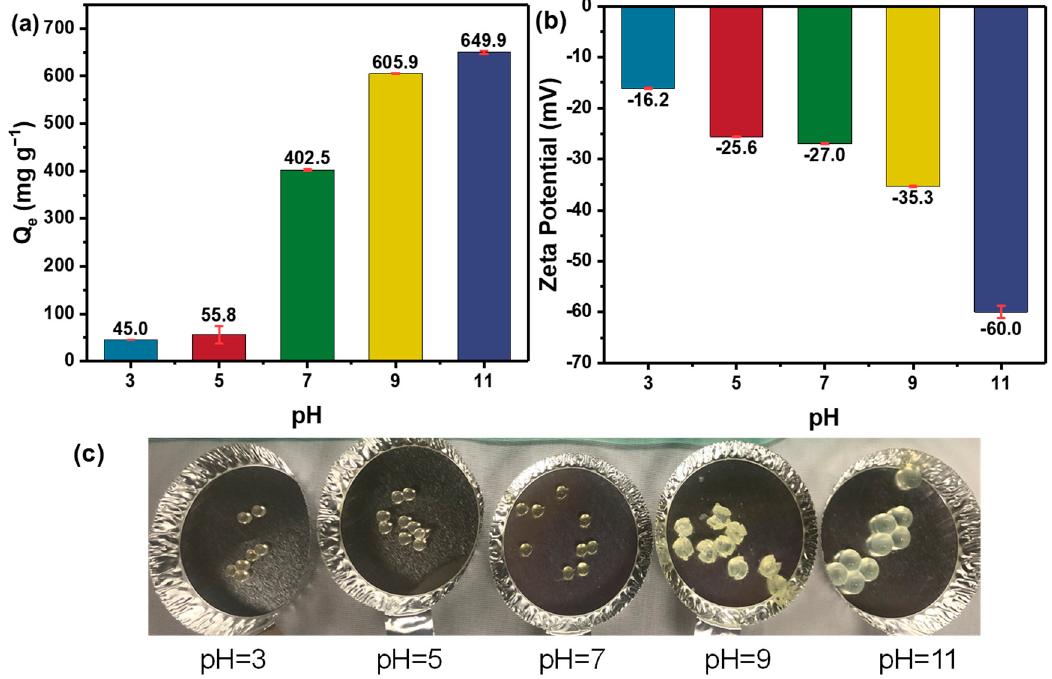
Figure 10. ( a ) Effect of pH on the adsorption for DOXY on the SA–DCNC-40 hydrogel beads, ( b ) zeta potential of SA–DCNC-40 mixed suspension, and ( c ) photographs of SA–DCNC-40 hydrogel beads after adsorption under different pH conditions.